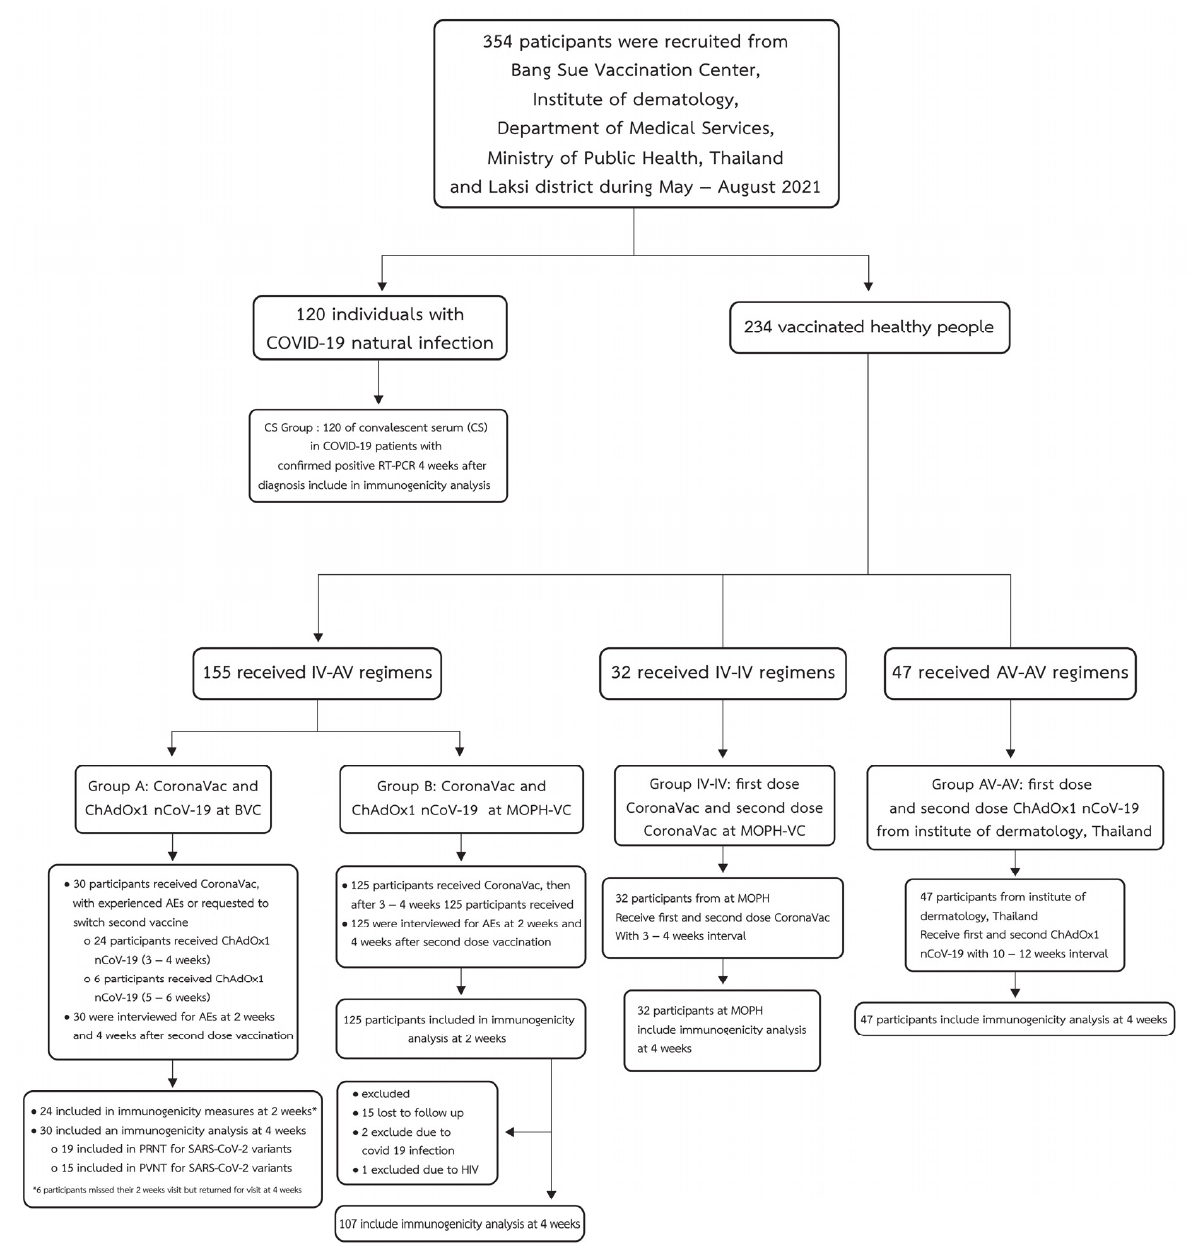
Figure 1. Enrollment diagram of the study population. In total, 354 participants were recruited from Bang Sue Central Vaccination Center, Institute of Dermatology, Ministry of Public Health, Thailand, and Lak Si District. The cohort was divided into 2 groups: (1) 120 individuals with natural COVID-19 infection and (2) 234 vaccinated people. The vaccinated group was classified into 3 subgroups according to the type of vaccine: 155 IV-AV, 32 IV-IV, and 47 AV-AV courses. ( IV stands for CoronaVac, AV stands for ChAdOx1, CS group stands for convalescent serum in COVID-19 patients with confirmed positive RT-PCR 4 weeks after diagnosis ) .